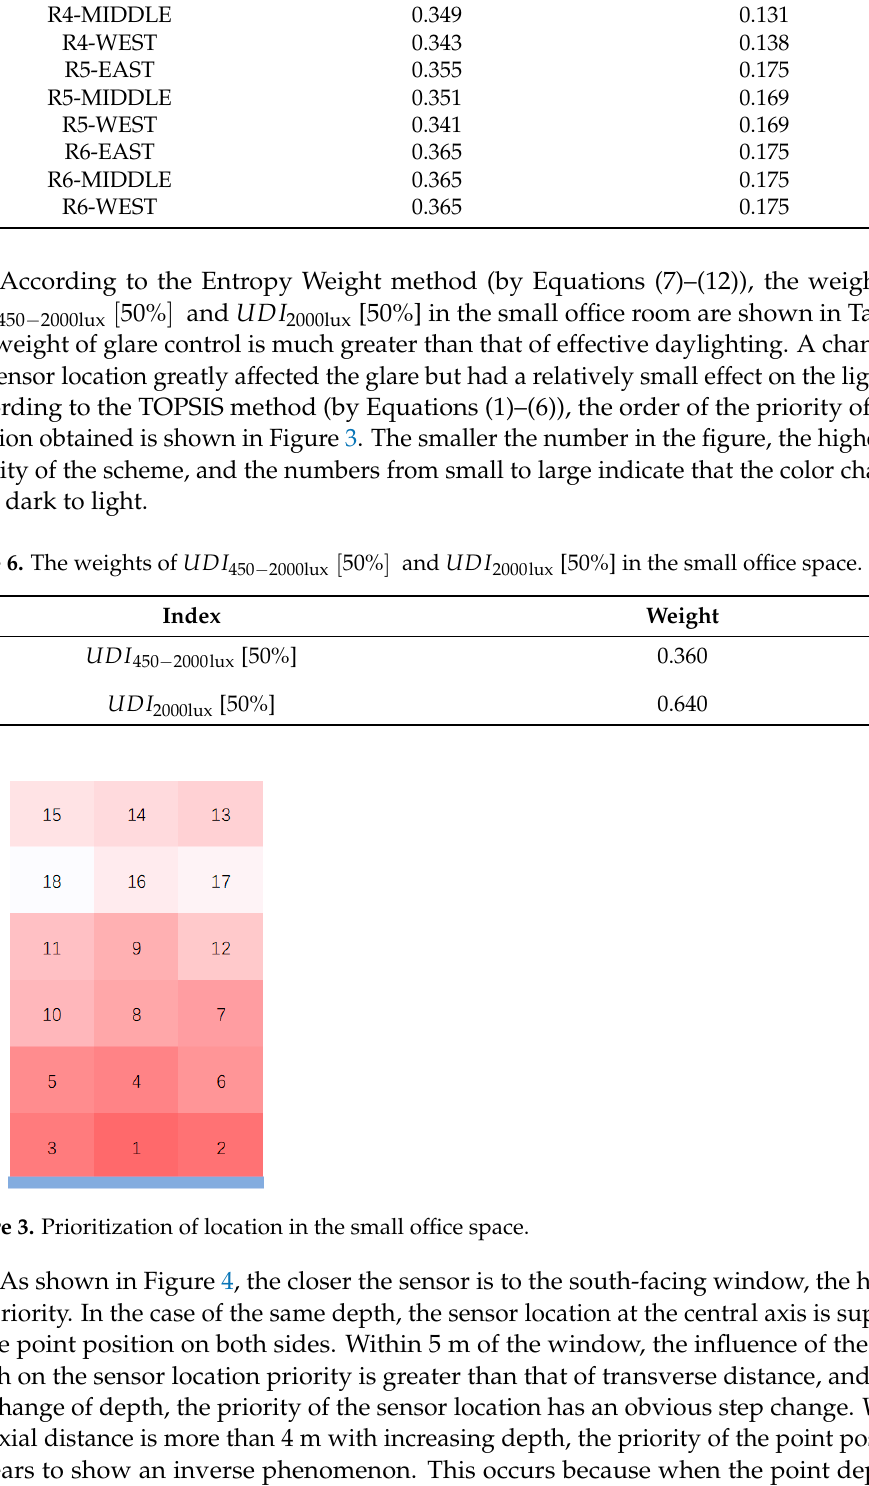
Figure 4. Priorities of each depth of the small office space.